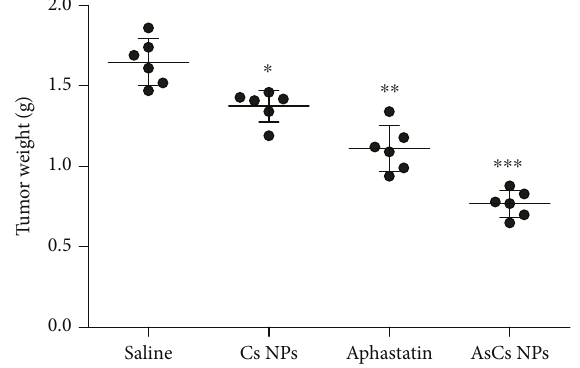
Figure 6: E ff ects of AsCs NPs on tumor weights from LA975 tumor-bearing mice. ∗ P < 0 05 , ∗∗ P < 0 01 , and ∗∗∗ P < 0 001 versus saline